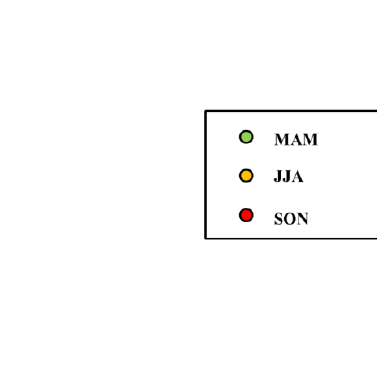
Figure 8. Coefficient of variation (CV) of the ASAR SM mean, evaluated for each ASAR acquisition over the FMI and GTK ECV sized pixels, during the observation period 2007–2009 for Sodankylä, Ilomantsi and Kuusamo, 2007–2010 for Pori, and 2005–2009 for Suomussalmi. Seasonal based values are highlighted by different colors. (Spring: MAM; Summer: JJA; Autumn: SON).